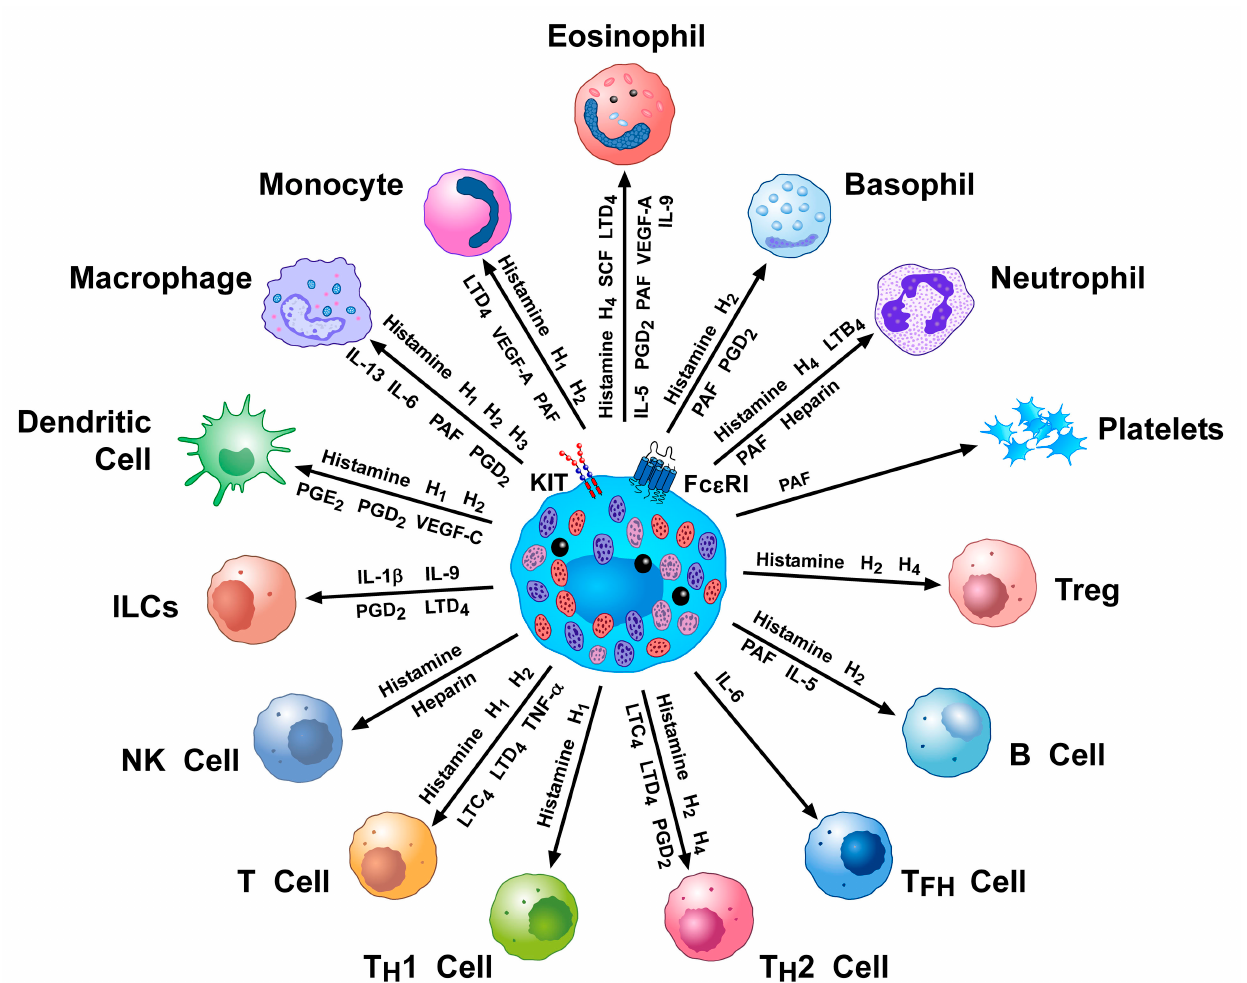
Figure 2. Schematic representation of the multiple interactions between human lung mast cells and several cells of the innate and adaptive immune system through the release of mediators. Mast cells can interact with monocytes (histamine, LTD 4 , VEGF ‐ A, and PAF), macrophages (histamine, IL ‐ 13, IL ‐ 6, PAF, and PGD 2 ), dendritic cells (DCs) (histamine, PGE 2 , PGD 2 , VEGF ‐ C, and IL ‐ 13), ILCs (IL ‐ 1 β , IL ‐ 9, PGD 2 , and LTD 4 ), NK cells (histamine and heparin), T cells (histamine, LTC 4 , LTD 4 , and TNF ‐α ), T H 1 (histamine) and T H 2 (histamine, LTC 4 , LTD 4 , and PGD 2 ) cells, T FH cells (IL ‐ 6), B cells (histamine, PAF, and IL ‐ 5), Treg cells (histamine), eosinophils (histamine, IL ‐ 5, IL ‐ 9, SCF, LTD 4 , PAF, PGD 2 , and VEGF ‐ A), neutrophils (histamine, LTB 4 , PAF, and heparin), basophils (histamine, PAF, and PGD 2 ), and platelets (PAF). Modified with permission from Varricchi 2019 [151].